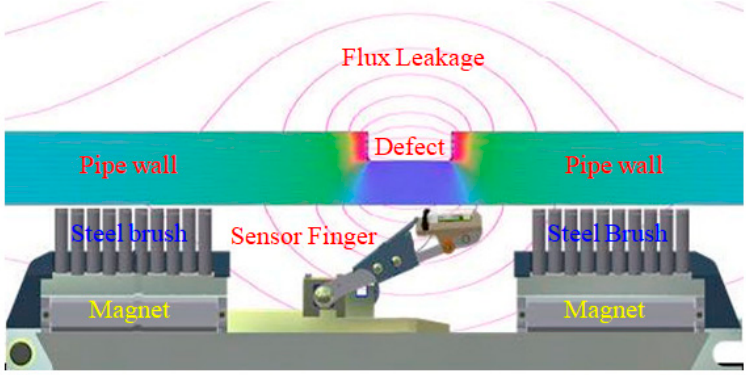
Figure 2. The magnetic flux leakage principle.